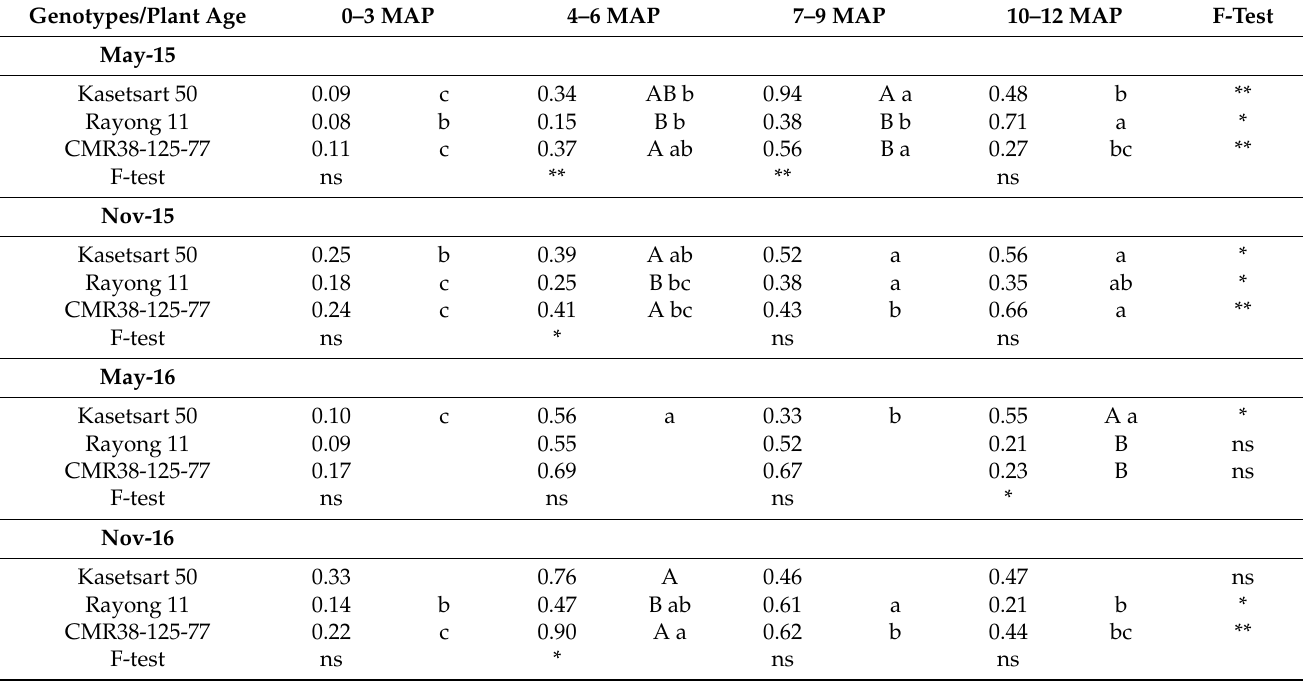
Table 3. Radiation use efficiency (g MJ − 1 ) for storage root dry weight of 3 cassava genotypes in different growth stages for May and November plants for 2